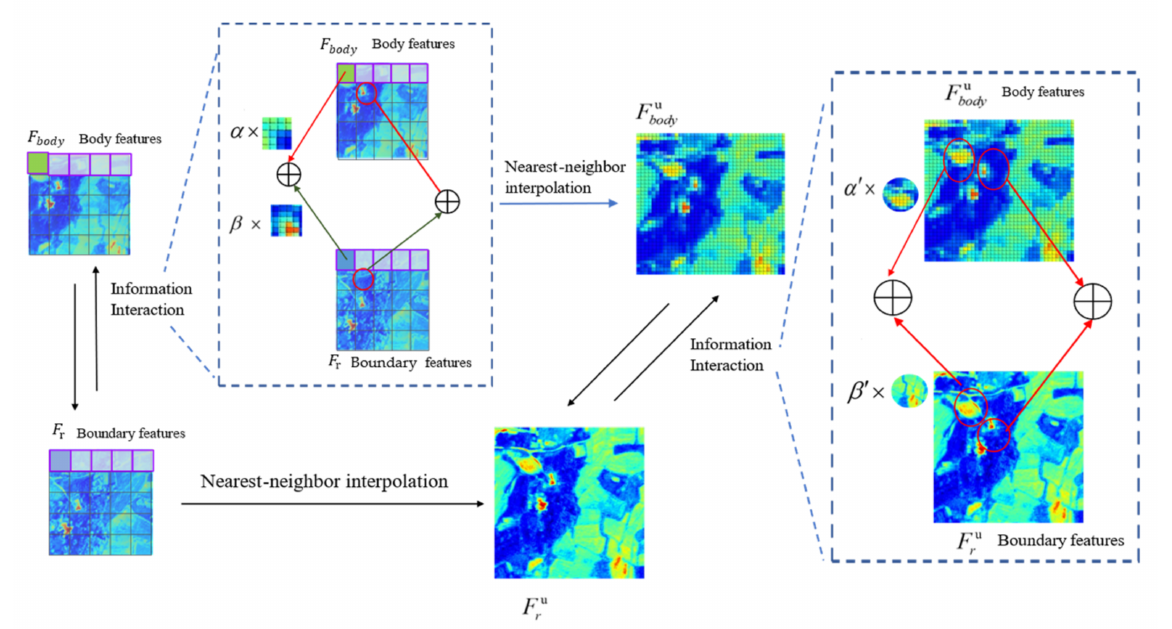
Figure 7. The structure of the interaction between boundary features and body features. α , β , α (cid:48) , and β (cid:48) are the learnable scalar weights of the input body information. The boundary features F r and the body features F body have the same size. The boundary features F u r and the body features F u the same